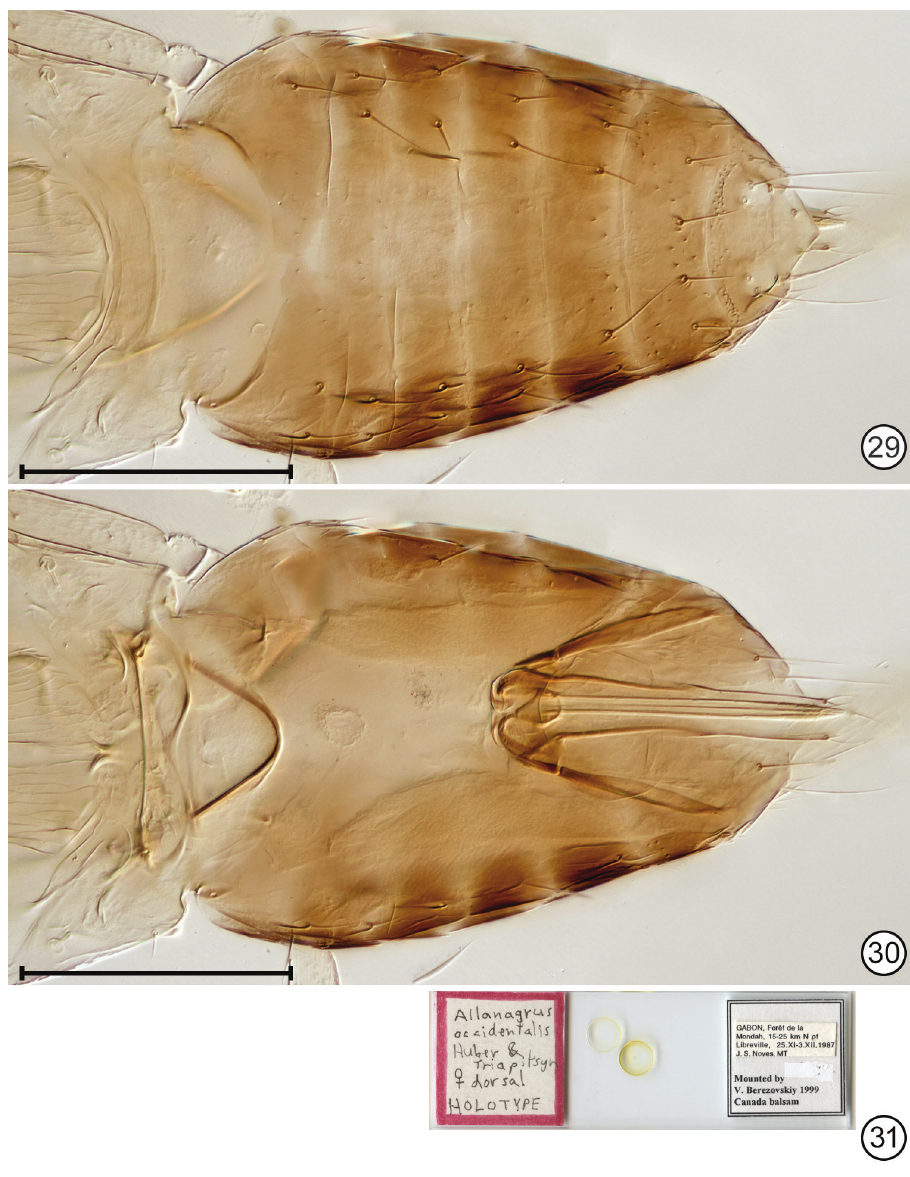
Figures 29–31. Paranaphoidea occidentalis holotype 29 apex of mesosma + metasoma, dorsal 30 apex of mesosma + metasoma as seen through body 31 holotype slide. Scale bars: 100